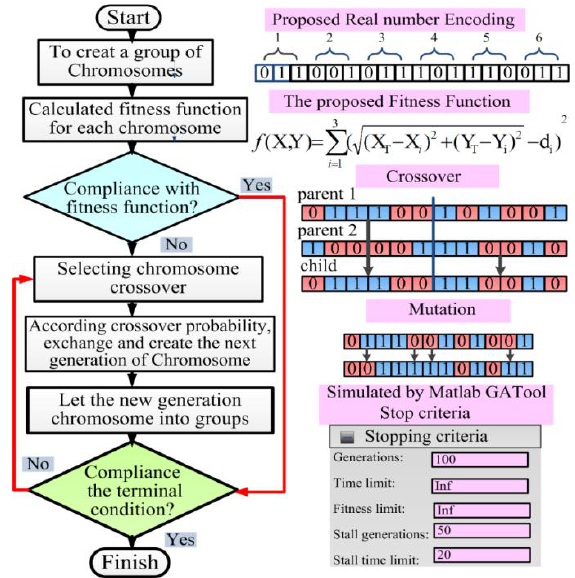
Figure 8. The procedure of proposed genetic algorithm applied in TDOA-based locating